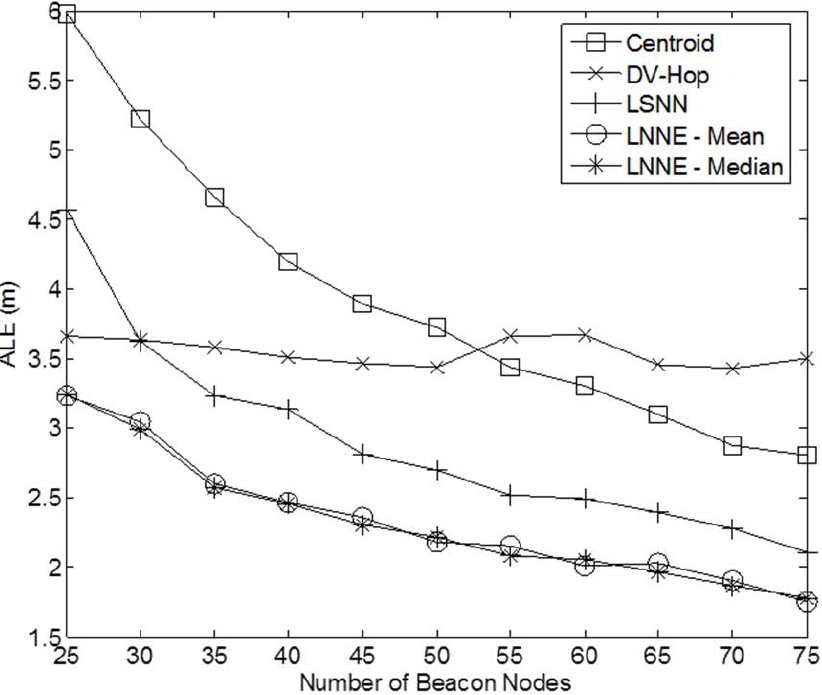
Figure 10. Performance comparison under different beacon ratios (0.1–0.3) and 5 coverage